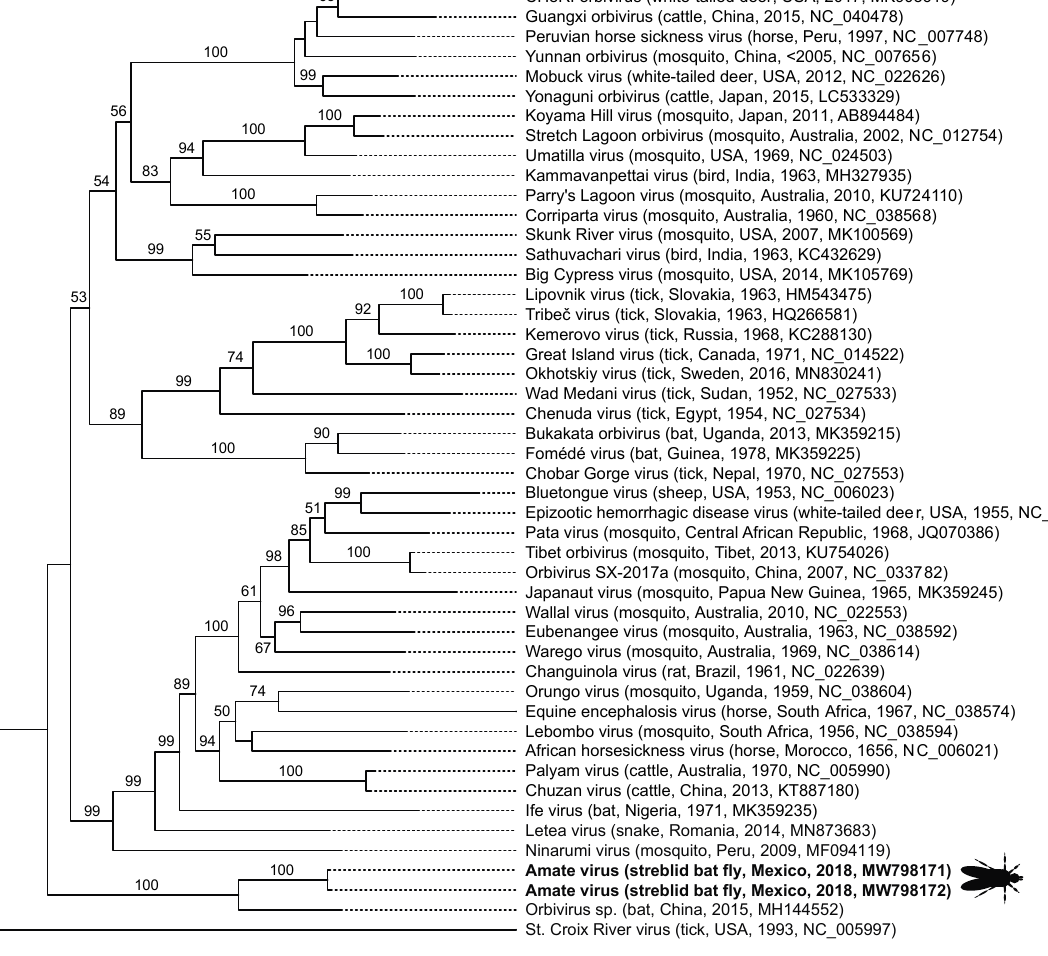
Figure 4. Maximum likelihood phylogenetic tree of orbiviruses based on VP1 (polymerase) gene sequences. Virus names are followed (in parentheses) by host, country, year of collection, and GenBank accession number. The two closely related variants of Amate virus (98.7% nucleotide identity in the VP1 gene) identified in the present study, are shown in bold type with silhouette of streblid bat fly. Numbers beside branches represent statistical confidence in clades based on 1000 bootstrap replicates; only bootstrap values ≥ 50% are shown. Scale bar = nucleotide substitutions per site.